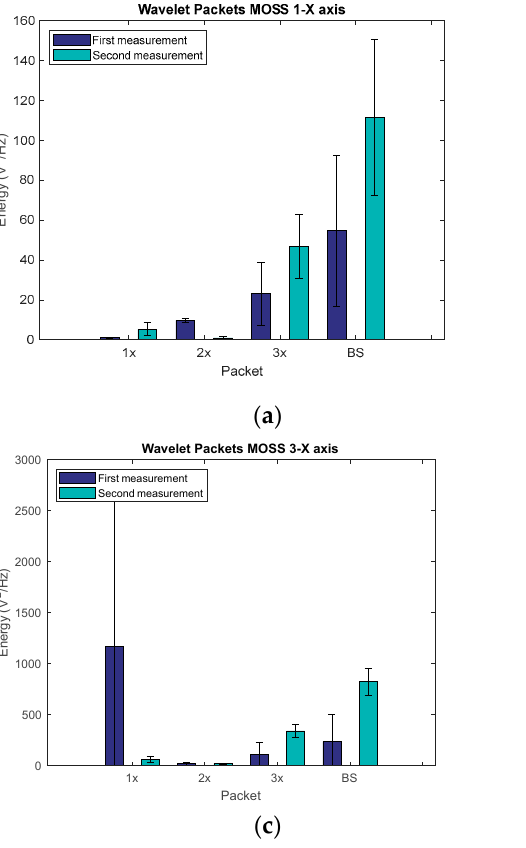
Figure 5. Energy variation between first and second measurements on the X axis: ( a ) MOSS 1; ( b ) MOSS 2; ( c ) MOSS 3; and ( d ) MOSS 4.